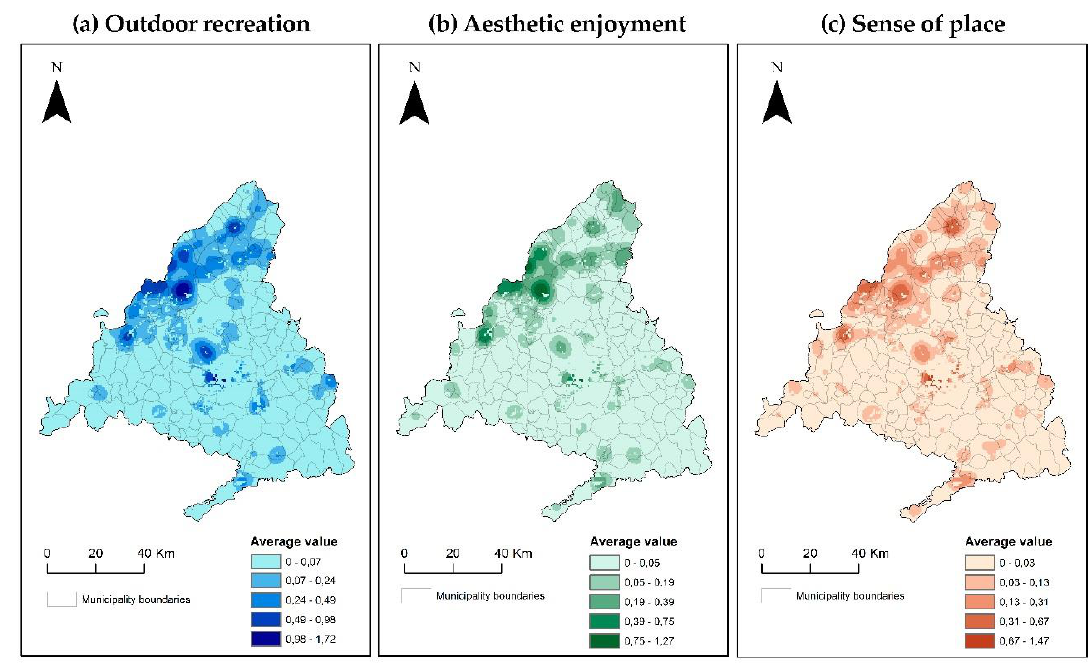
Figure 3. Graphical outputs of kernel density maps for the three cultural ecosystem services (CES).